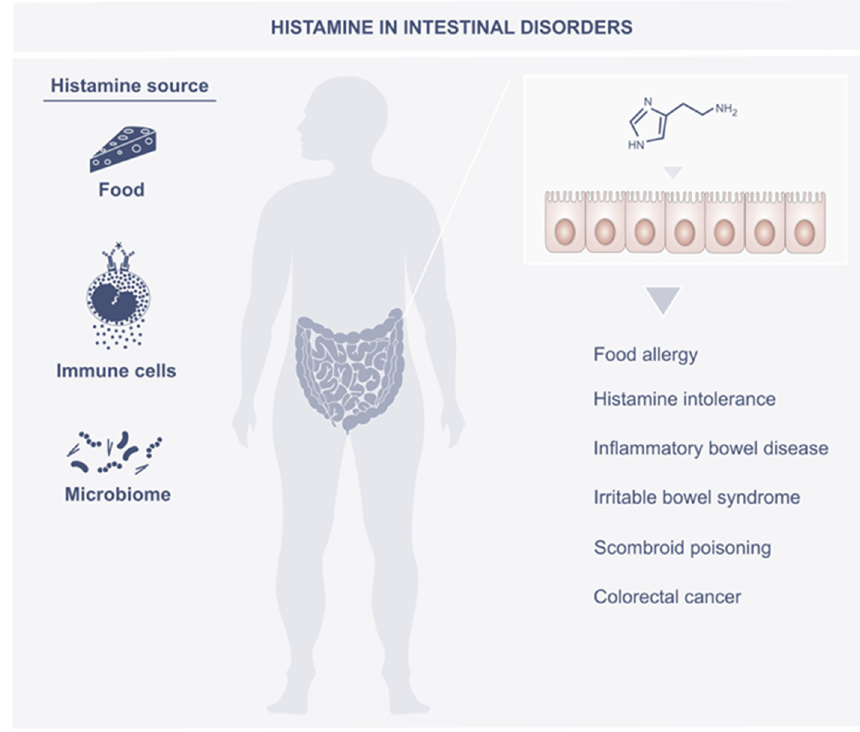
Figure 2. Histamine in intestine disorders.